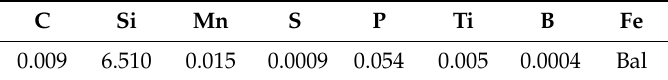
Table 1. Chemical composition of Fe-6.5wt. %Si alloy (wt.